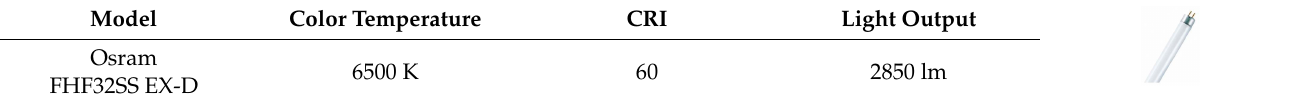
Table 7. Specifications of photometer (Luton LM-81LX). Model